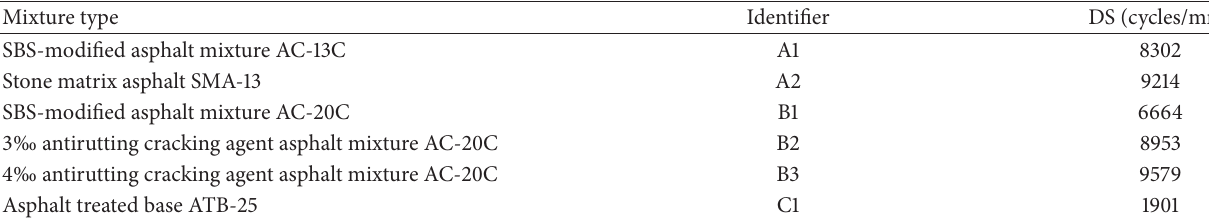
Table 3: Wheel tracking test results of different asphalt mixtures.